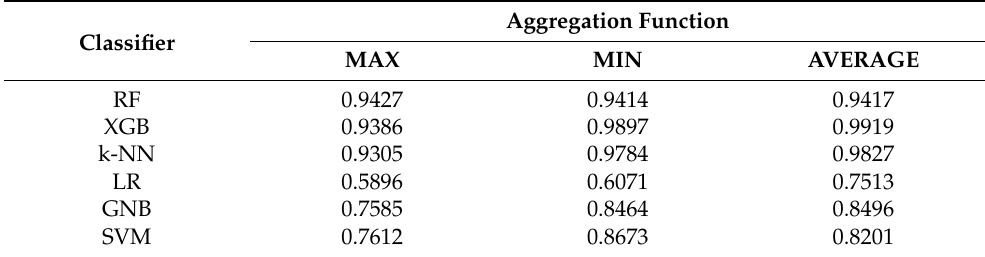
Table 9. Accuracy of classifiers with MI feature selection on the test dataset.